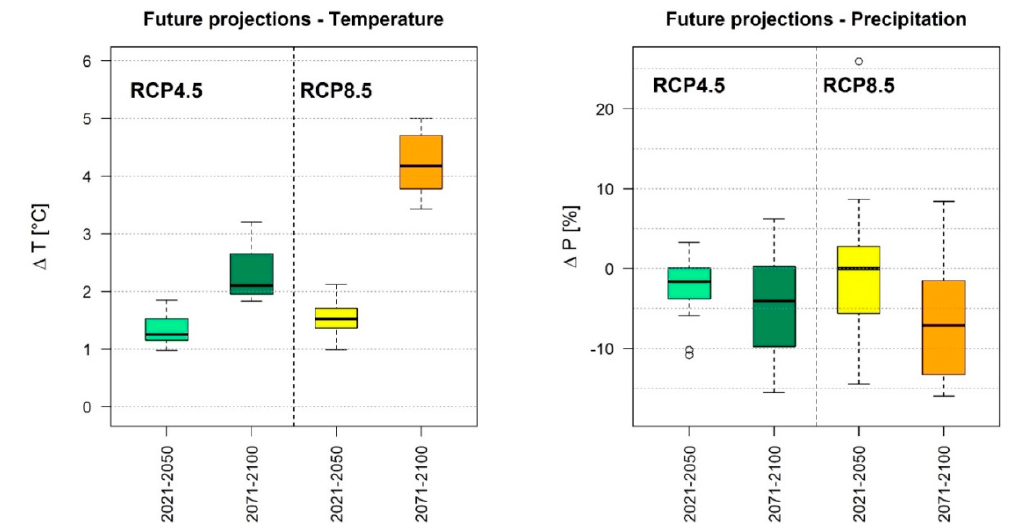
Figure 7. Climate change signals for temperature ( left ) and precipitation ( right ) as projected by an ensemble of 20 GCM–RCM combinations from the CORDEX Africa project based on the RCP4.5 and RCP8.5 for a near (2021–2050) and far future (2071–2100) period with reference to the 1976 to 2005 period.